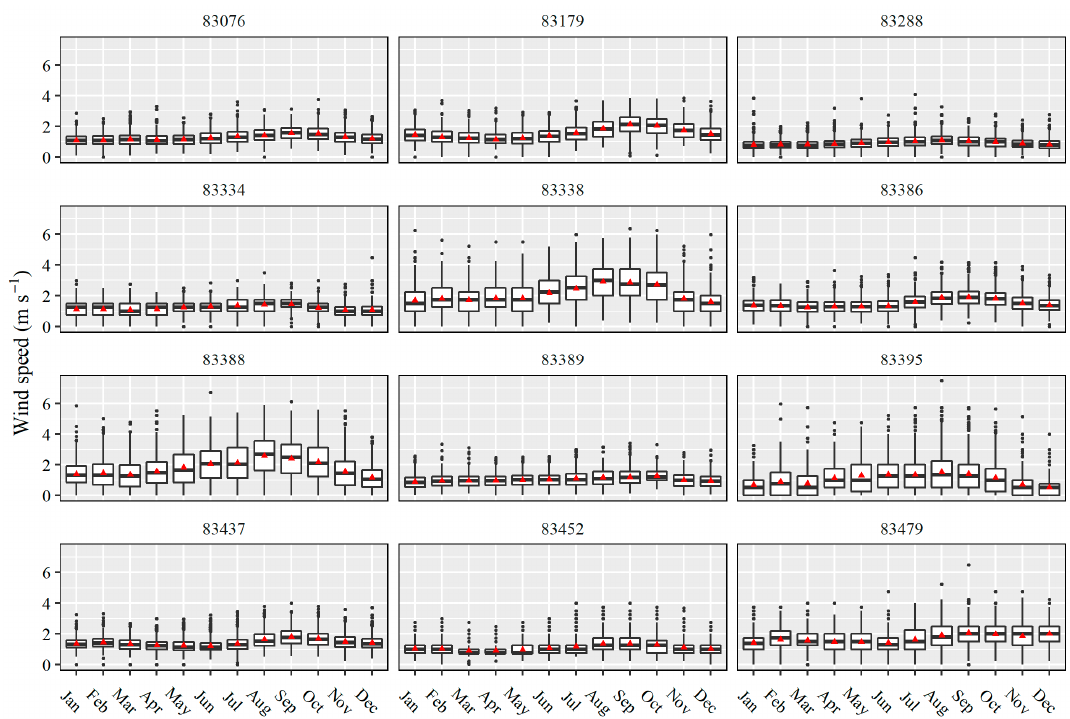
Figure 5. Daily wind speed by month and station.